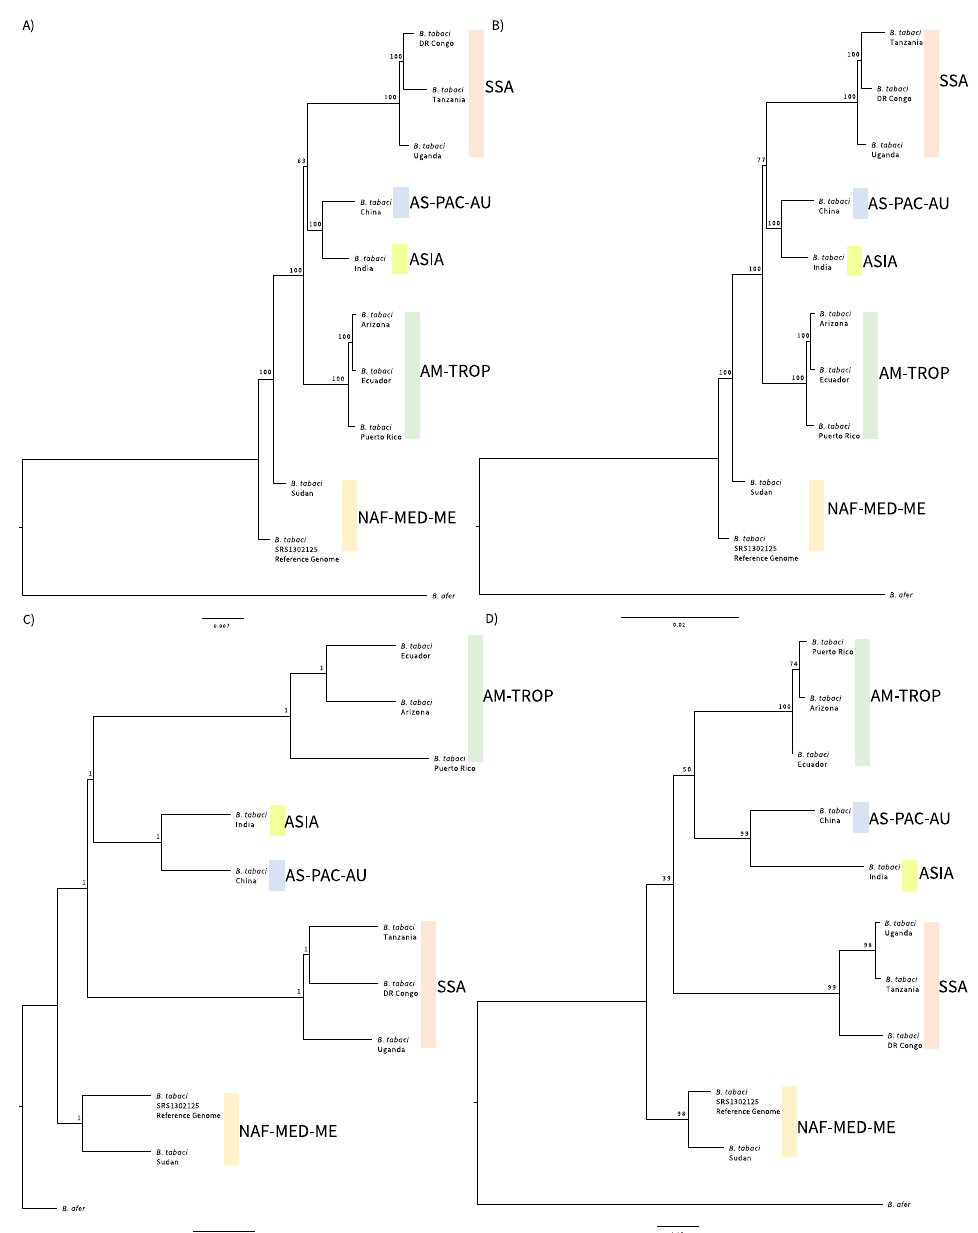
Figure 1. Colors correspond results suggested by automatic barcode gap discovery (ABGD) tests for putative species. ( A ) Result of the concatenated maximum likelihood (ML) analysis of all nucleotide sites from the nuclear supermatrix (lnLikelihood = –6919264.24). Scale bar represents substitutions per site. Clade values are depicted as bootstrap support. ( B ) Result of the partitioned ML analysis of the nuclear supermatrix (lnLikelihood = –6907791.99). Scale bar represents substitutions per site. Clade values are depicted as bootstrap support. ( C ) Result of ASTRAL coalescent analysis of 2184 gene trees. Scale bar represents coalescent units. Clade values are depicted as local posterior probabilities. ( D ) Result of ML analysis of cytochrome oxidase I (COI) sequences obtained from read-mapping (lnLikelihood = − 6174.94). Scale bar represents substitutions per site. Clade values are depicted as bootstrap support.